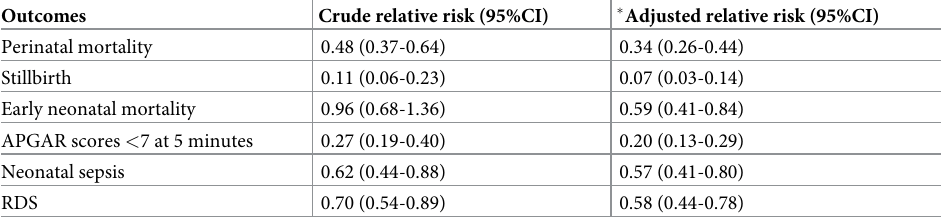
� Adjusted for gestational age, birth weight, level of health facility, multiple pregnancy, delivery mode, while neonate sex, maternal antibiotics, neonatal antibiotics, parity, antenatal care attendance days, maternal infection and fetal heart rate were not significant hence removed from the